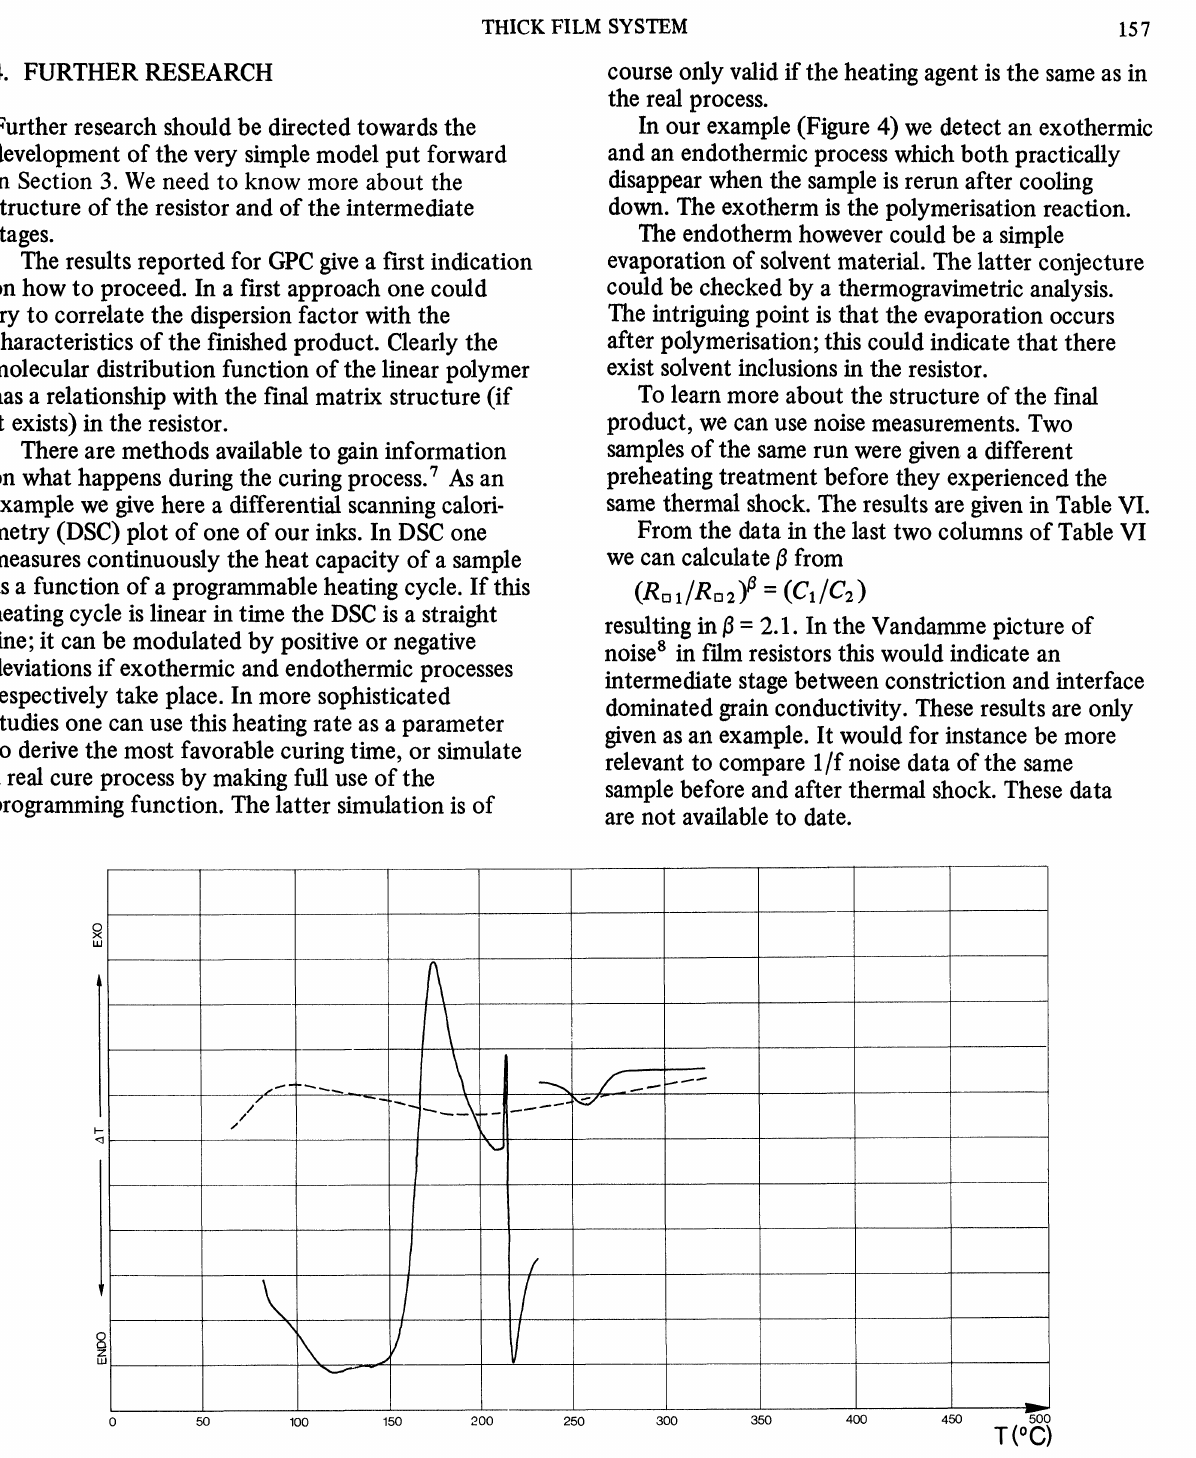
An example of DSC plot for one of our inks. Sample temperature is given in the abscissa in C. The meaning of the ordinate is explained in Section 4. Heating rate was 20 C/min under N atmosphere. The broken line is a plot for the same sample after the first experiment (full curve) was